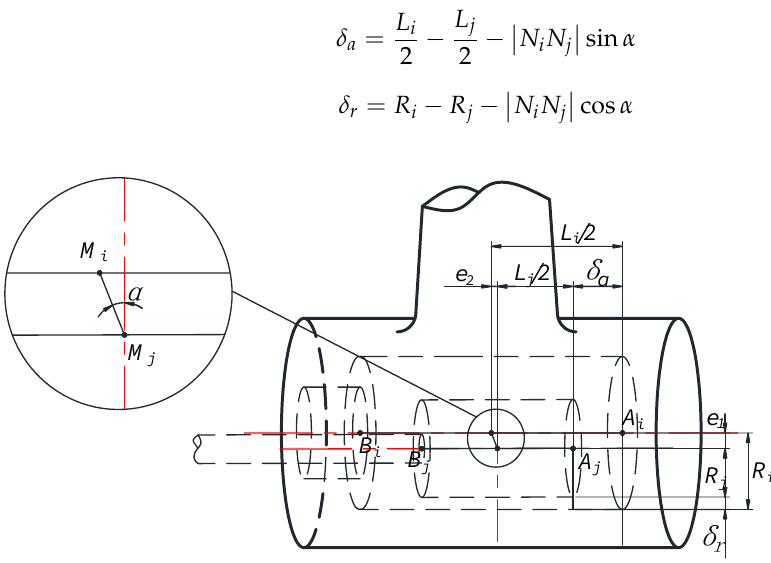
Figure 5. Bearing and journal axes in parallel.